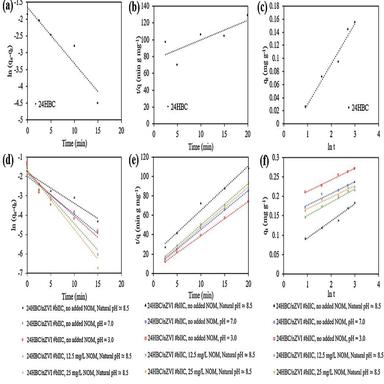
Kinetics of TCE removal by using: 24HBC at natural pH ' 8.5 with no added NOM; fitted to (a) pseudo-first order, (b) pseudo-second order, and (c) Elovich models; and by using 24HBC/nZVI #bIIC in various pH values and NOM concentrations, fitted to (d) pseudo-first order, (e) pseudo-second order, and (f) Elovich models.